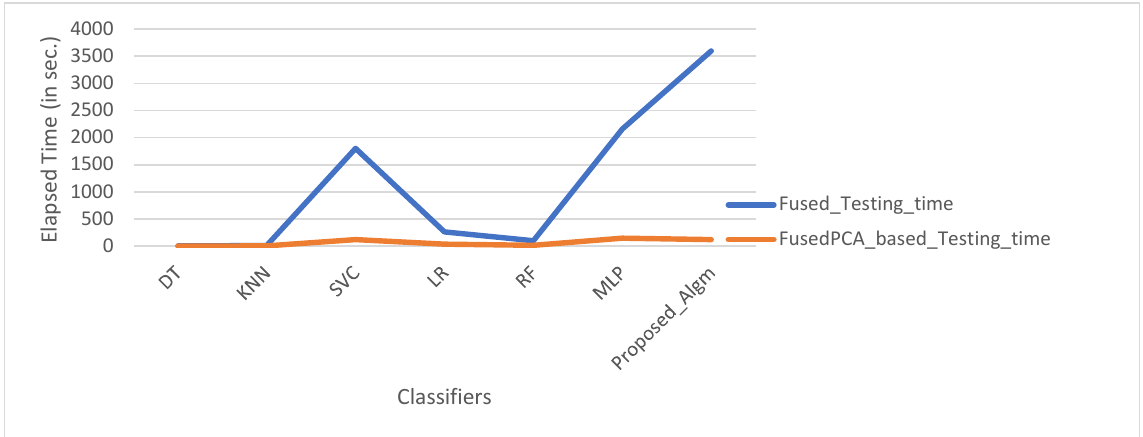
Figure 9. Comparative analysis of computational testing time of the fused data before and after PCA applied.